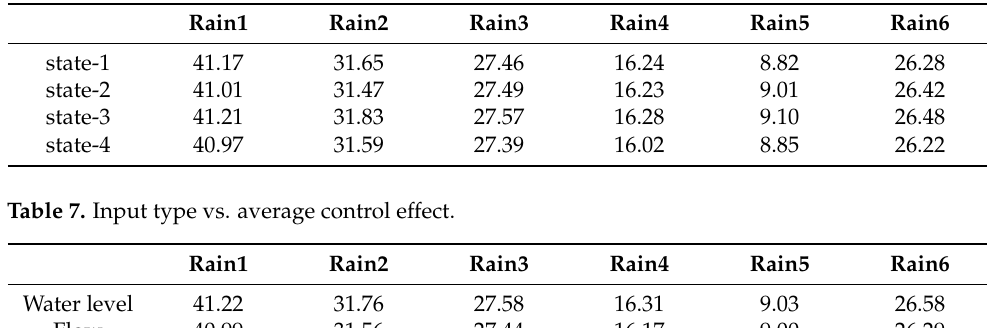
Table 6. Node number and location vs. average control